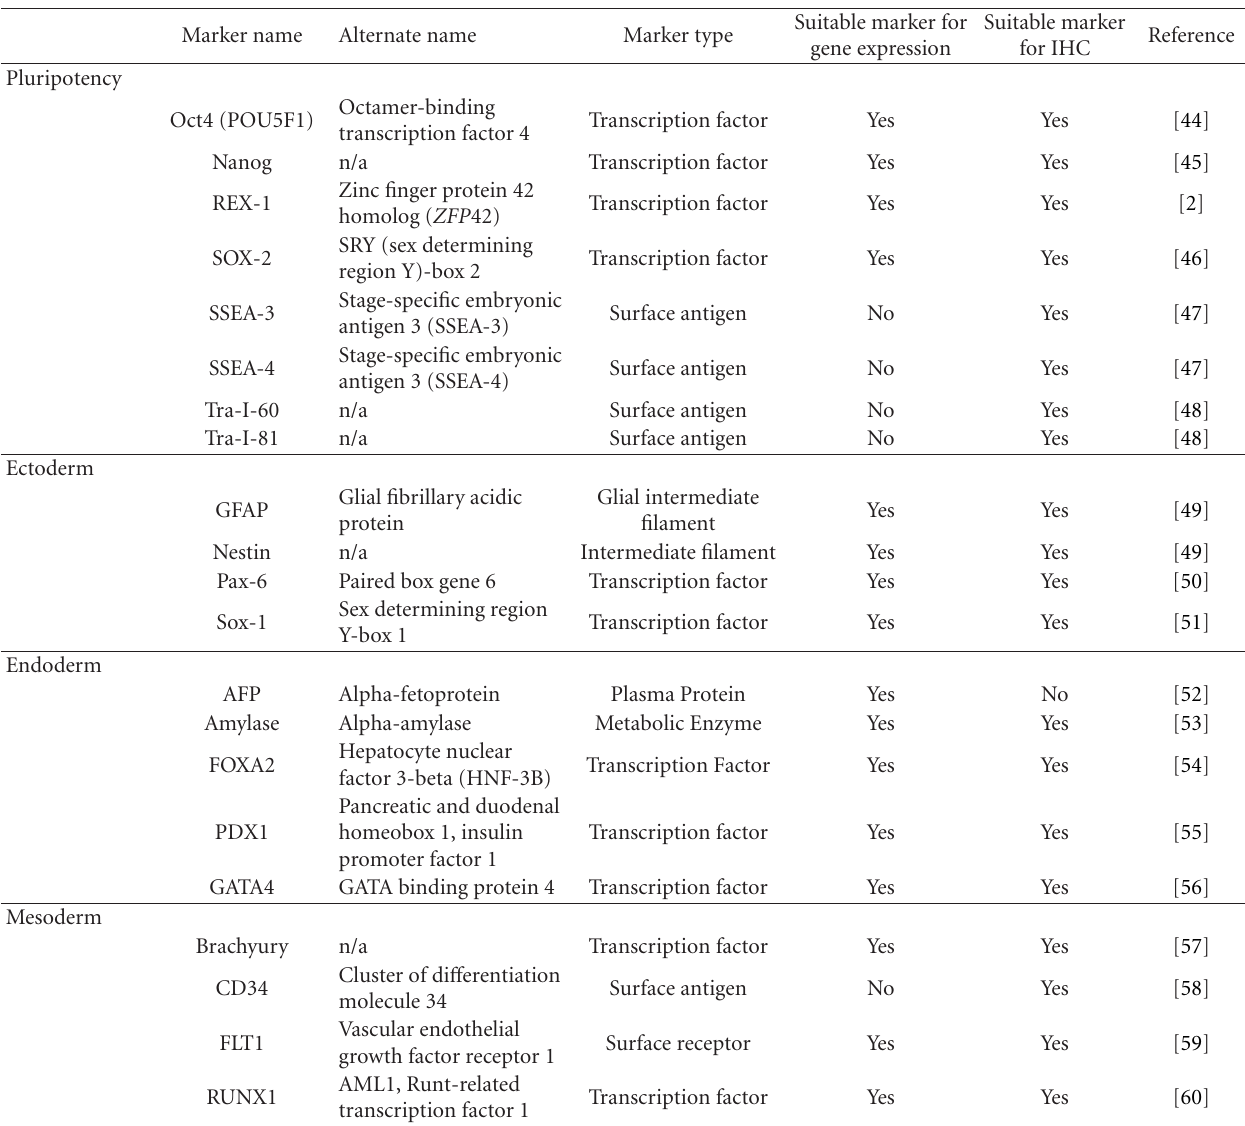
Table 2: Typical markers for the analysis of human embryoid